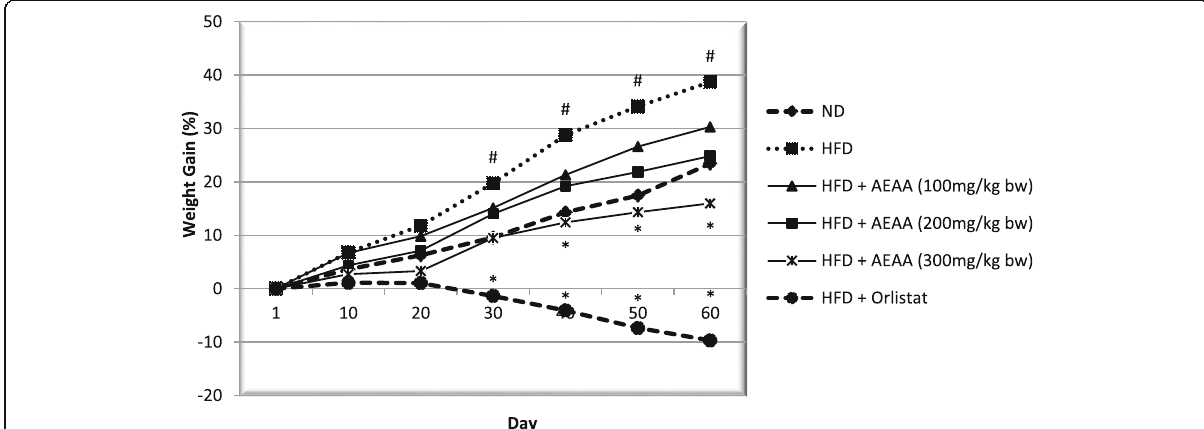
Fig. 5 Percentage Body Weight Gain in experimental rats; values are mean of 6 rats; # p < 0.05, significantly different from ND fed group; *p < 0.05, significantly different from HFD administered group; AEAA – Aqueous Extract of Achyranthes aspera L.; ND – Normal Diet; HFD – High Fat Diet